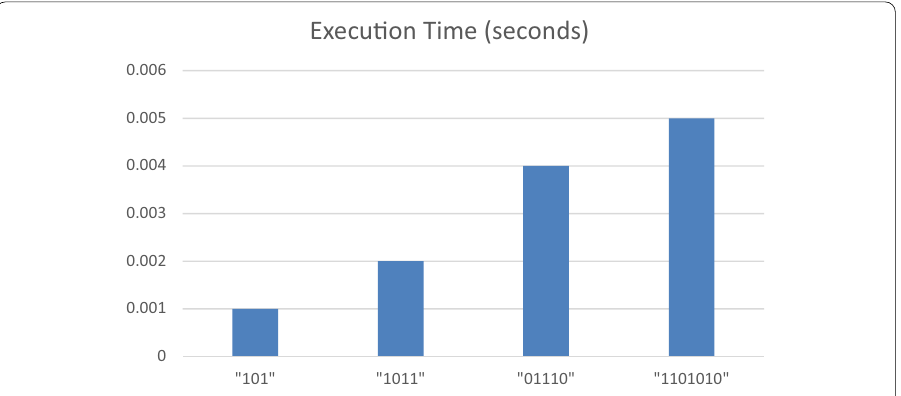
0 Fig. 27 Execution times of quantum bit strings—rotation by bit